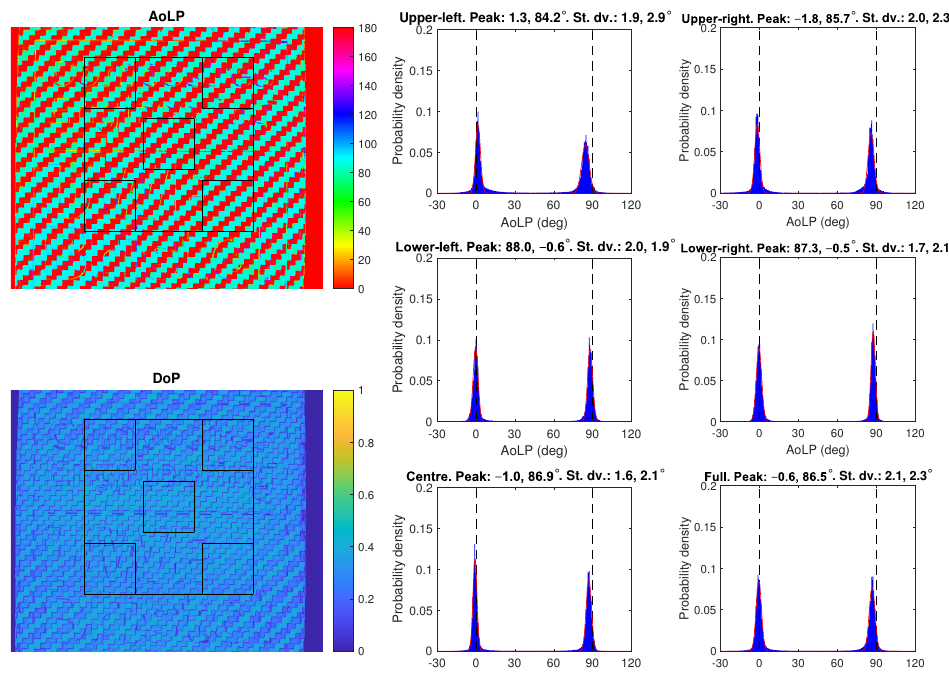
Figure 14. Results for a cured woven sample taken in similar conditions to the case of Figure